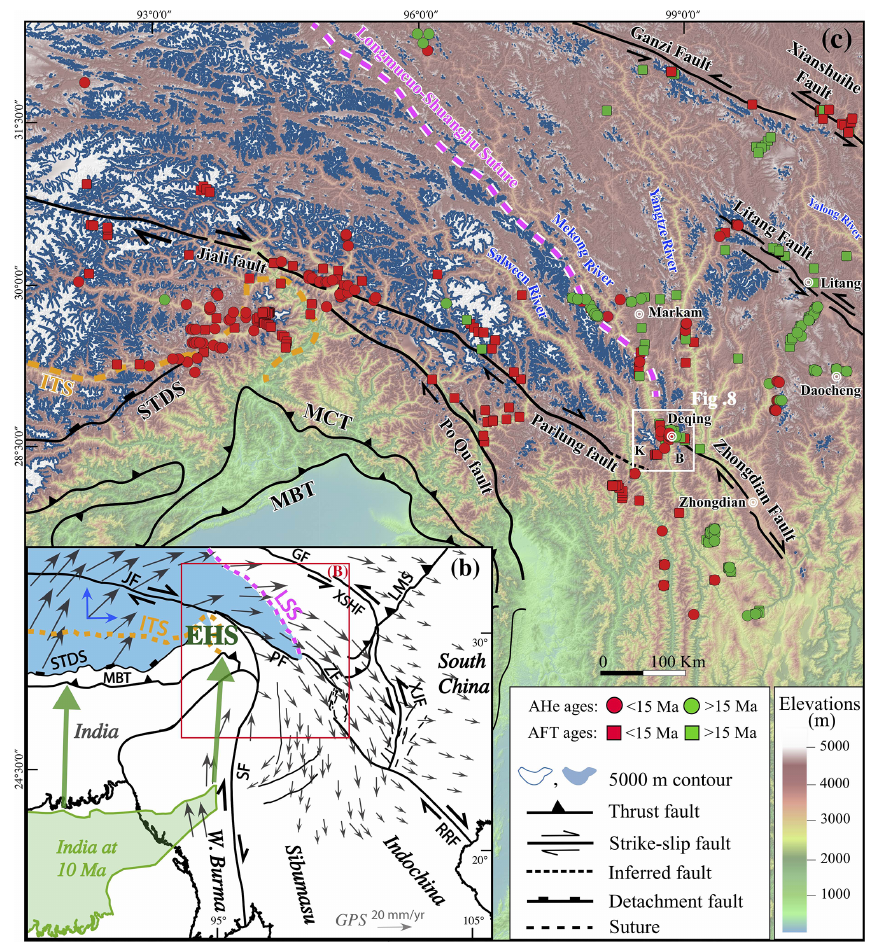
Figure 9. (a) Simplified geological structures of south-east Tibet, with GPS velocity field (modified from Wang et al., 2017), showing a N–S component of motion north of India. Blue patch is the area of average elevation above 5000m on the Tibetan Plateau. The reconstructed position of Indian continent at 10Ma (green contour from Replumaz and Tapponnier, 2003) shows continuing convergence since that time (green north-directed arrows). (c) Correlation between thermochronological (AHe and AFT) ages in south-east Tibet and topography above 5000m (blue contour). White square represents our study area. More additional data are from Burg et al. (1998), Ding and Wang (1995), Seward and Burg (2008), Tu et al. (2015), Yu et al. (2011), and Zhang et al. (2015) (see Fig. 1 for references of other thermochronological ages). Abbreviations: GF, Ganzi Fault; ITS, Indus–Tsangpo Suture; JF, Jiali Fault; LMS, Longmenshan thrust system; LSS,